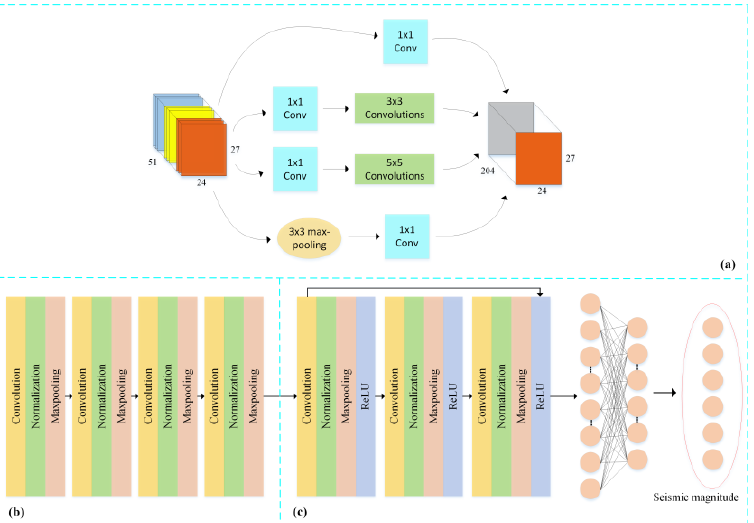
Figure 7. The detailed structure of our model. ( a ) High-Dimensional-Feature-Extraction block, ( b ) Temporal-Correlation block, and ( c ) Classification